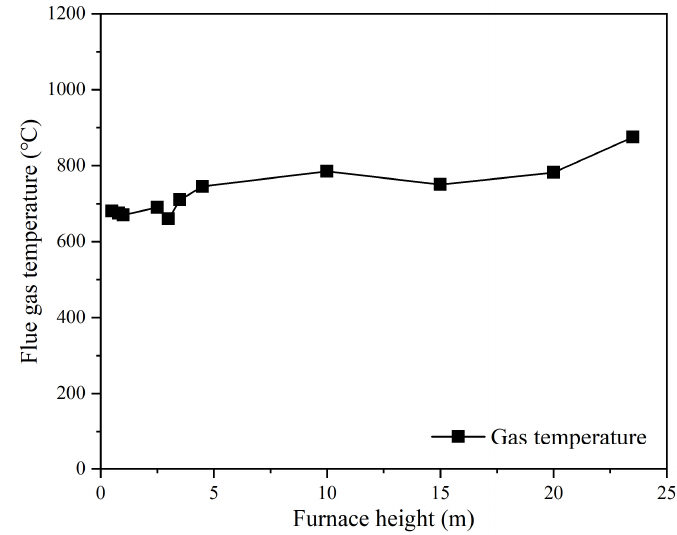
Figure 11. The average temperature of flue gas distributed along the furnace height in Case 2.